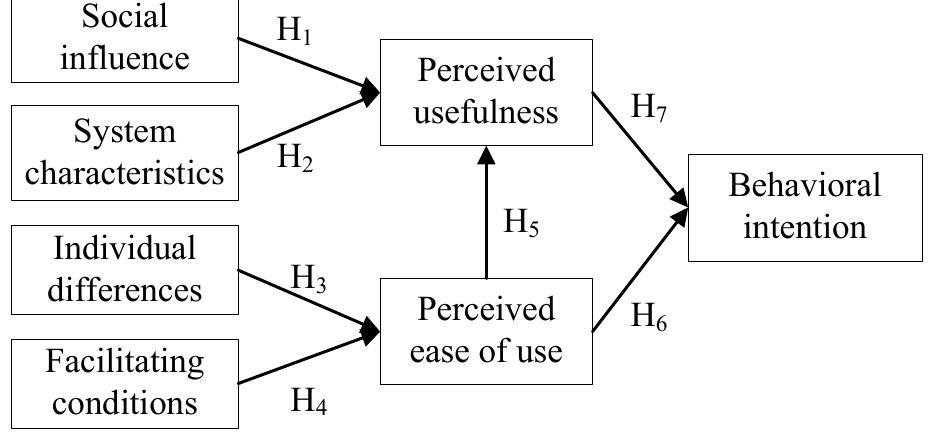
Figure 2. The research